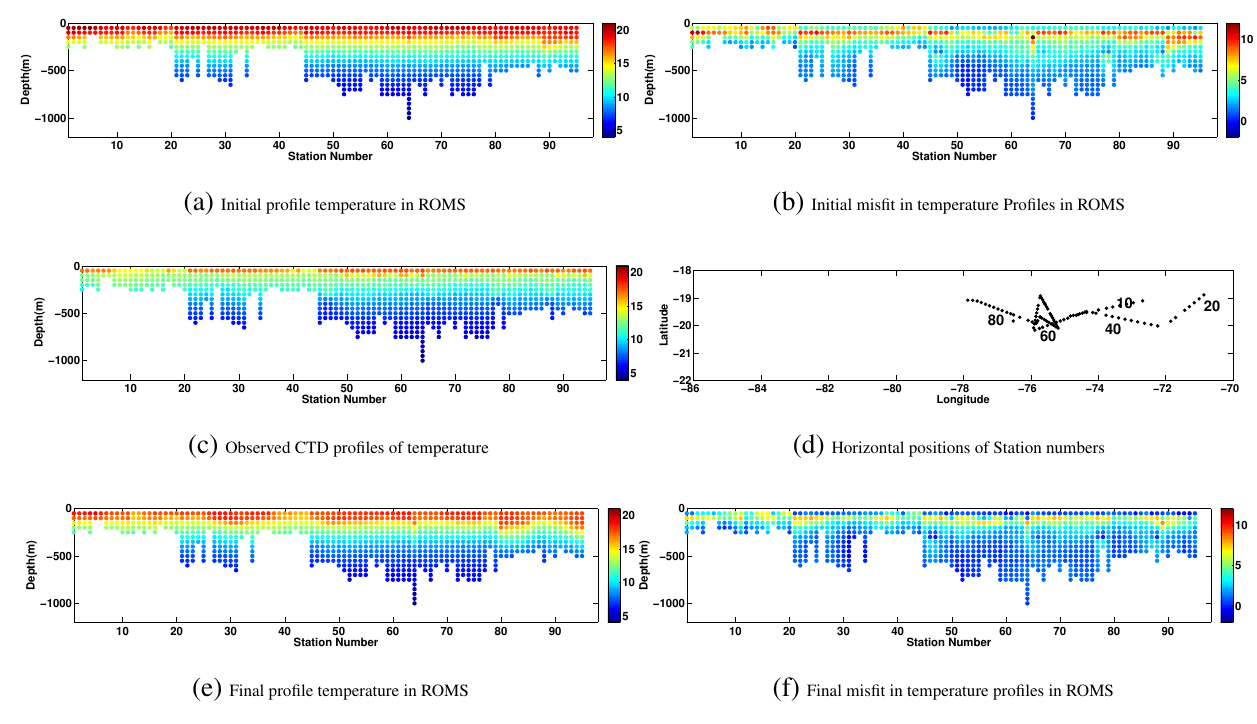
Fig. 5. (a, e) Model temperature profile values (in ◦ C) before and after assimilation. (c) shows the observed temperature profiles in the same location. The horizontal location of the profiles are shown in (d) which are the same as in the first leg shown in Fig. 1. The initial model misfit before assimilation (d) and the final model misfit after assimilation (f) for the first 15 day fit from 1 to 15 November 2008 is also